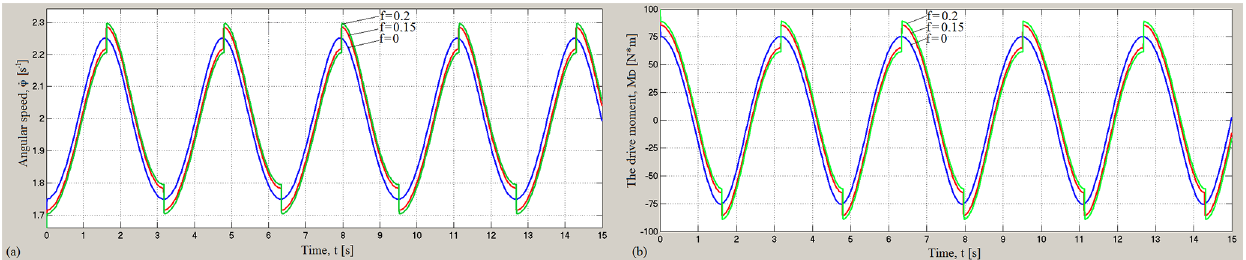
Figure 10. Dependencies of angular velocity (a) and engine torque (b) on the time at different values of the coefficient of sliding friction f and for value of coefficient of rotational friction k = 0.